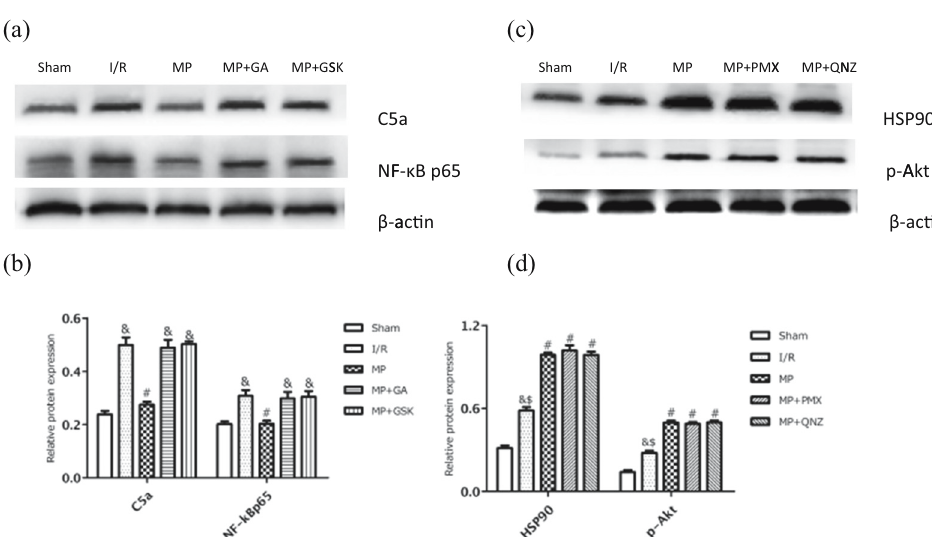
Figure 6: E ff ects of GA and GSK on C5a and NF - κ Bp65 protein expression. ( a ) Representative Western blots showing the expression of C5a and NF - κ Bp65. ( b ) Relative expression of C5a and NF - κ Bp65 proteins. ( c ) Representative Western blots showing the expression of HSP90 and p - Akt. ( d ) Relative expression of HSP90 and p - Akt proteins. Values are presented as mean ± standard deviation. # P < 0.05 vs I/R group; & P < 0.05 vs MP group; $ P > 0.05 vs MP + P MX group; n = 5 for each group. I/R: ischemia/reperfusion; MP: morphine postconditioning; GA: geldanamycin; GSK: GSK - 690693; PMX: PMX 205; QNZ: